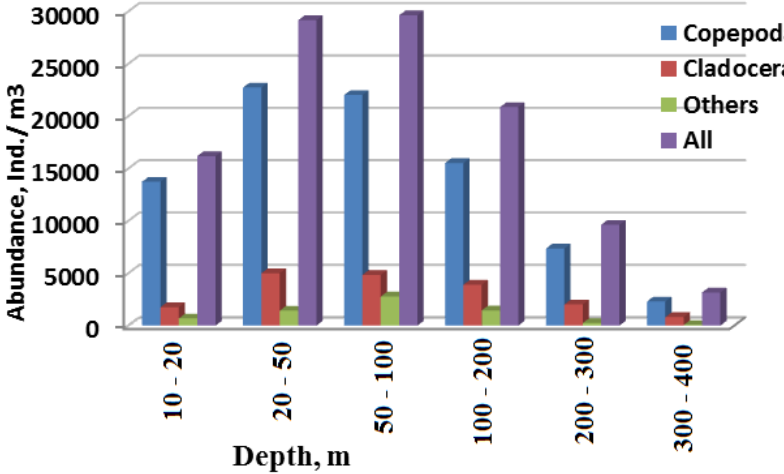
Figure 5. Changes in the number of zooplankton taxonomic groups with depth of the eastern section of the Middle Caspian, May 2016.